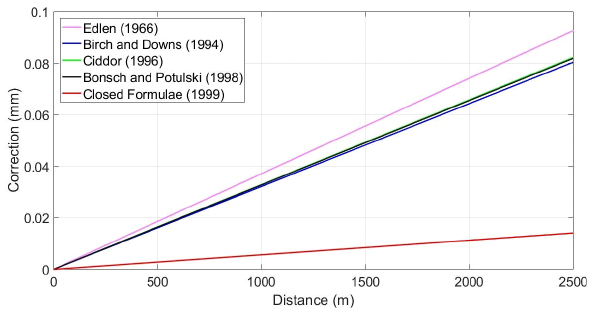
Figure 17. Correction vs. measured distance